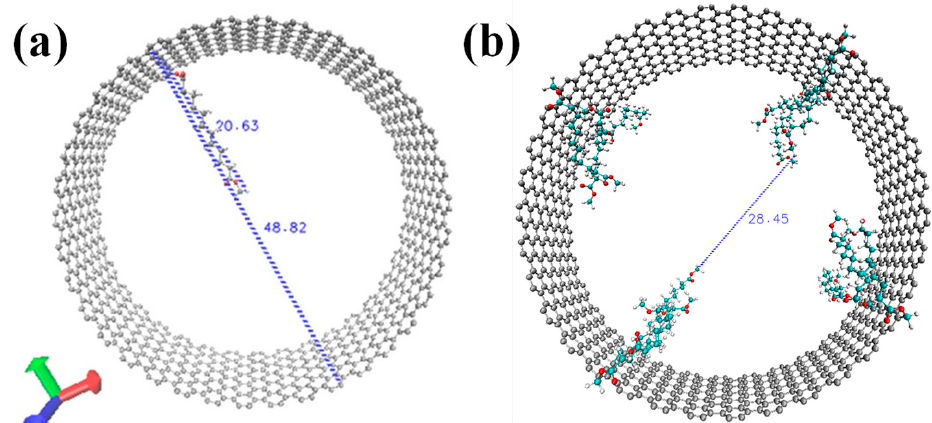
Figure 4. The bond length of 12-chloro-12-oxododecanedioic acid-methyl ester by NAMD simulation (20.63 Å), ( a ) one long chain and ( b ) multiple long chains.